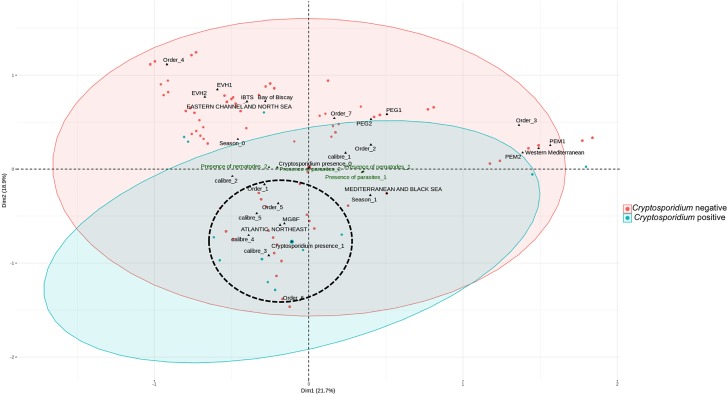
Multiple correspondence analysis. The cluster analysis explained 41% of the total variation. Variables which are closest to each other and distant from the center on the scatterplot are the most likely related. Even if these variables are not grouped as perfect clusters, most Cryptosporidium positive fishes are in the zone encircled (dot lines) that we called cluster 1. In general, this cluster contained larger fishes mainly of size and weight groupings (calibers) 4 and 5, from the order Gadiformes, caught in the North East Atlantic. PELGAS (PELagiques GAScone) 1, campaign 2011; PELGAS 2, campaign 2012; PELMED (PELagiques MEDiterranée) 1, campaign 2011; PELMED 2, campaign 2012; EVHOE (EValuation Halieutique de l’Ouest de l’Europe) 1, campaign 2011; EVHOE 2, campaign 2012; IBTS (International Bottom Trawl Survey), campaign 2012; MGBF, Retailers. Season 0, fall/winter; Season 1, spring/summer. Order 1, Gadiformes; Order 2, Perciformes; Order 3, Clupeiformes; Order 4, Lophiiformes; Order 5, Pleuronectiformes; Order 6, Salmoniformes; Order 7, others. Fishes were classified according to weight and size and five groups were defined ranging from 1-smallest fishes to 5-largest fishes (Supplementary Figure S1) using a hierarchical cluster analysis with the R stats package.